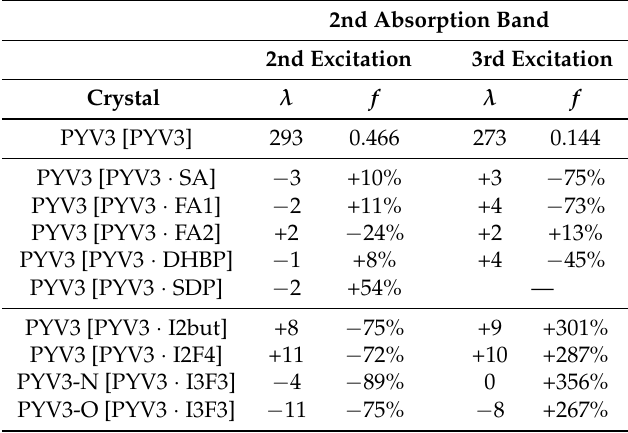
Table A4. RI-CC2/def2-TZVPD wavelengths of excitation, λ in nm, and oscillator strengths, f , for the enol PYV3 molecule in its crystal (PYV3 [PYV3]) and its co-crystals (PYV3 [PYV3 · XXX]). For PYV3 [PYV3], the absolute values are given while for the co-crystals, the absolute variations and relative variations are given for the wavelengths and oscillator strengths, respectively.